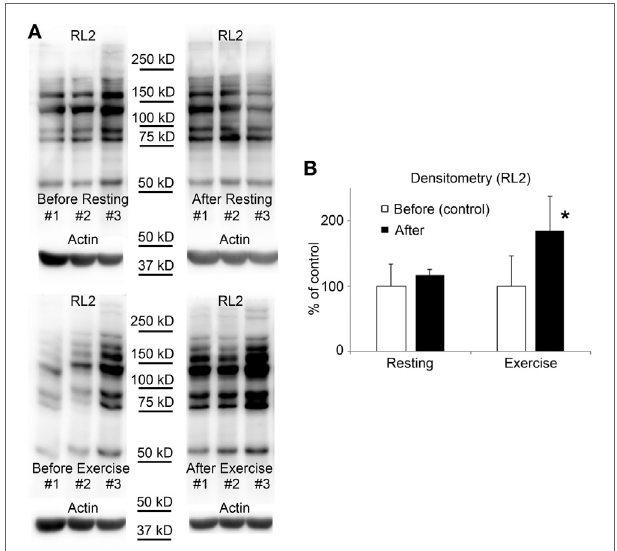
(a) Western blot analysis using RL2 antibody and anti-actin antibody shows samples of white blood cells protein extracts from three individuals. Sample were collected 3 h before exercise and before resting (left panels), and also after exercise and after resting (right panels). (B) Densitometry analysis of the RL2 staining is expressed as a percentage of the control samples (i.e., samples collected before exercise or before resting). Each data point shows the average of six individual samples. Open bars represent the mean ± SD of “before” samples and black bars represent the mean ± SD of “after” samples. * p < 0.05 vs before